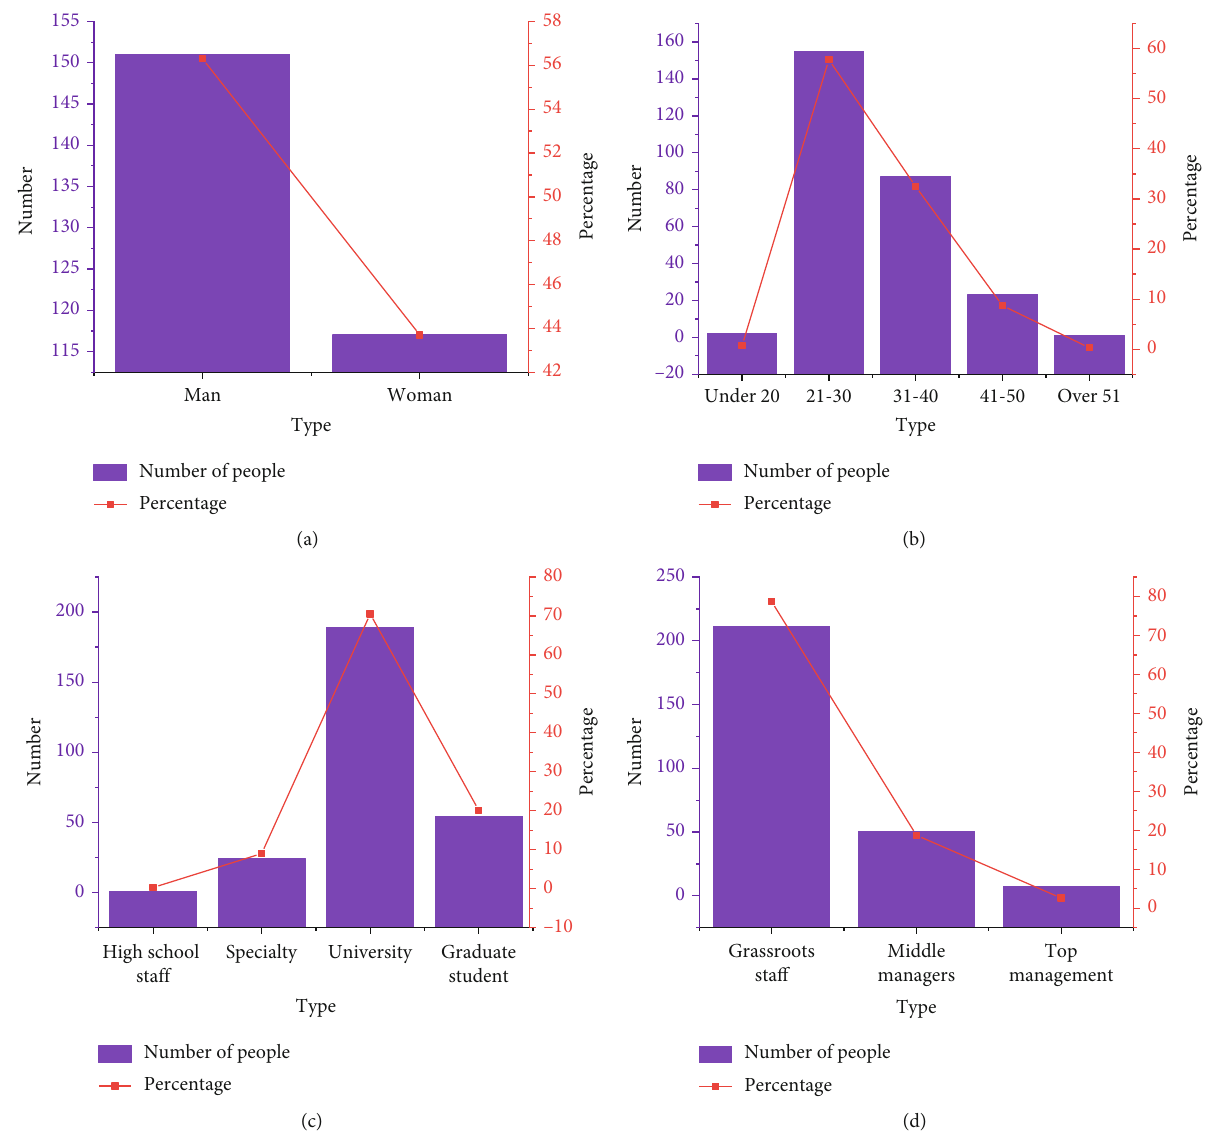
Figure 2: Descriptive statistical analysis ((a) gender, (b) age, (c) education, and (d)